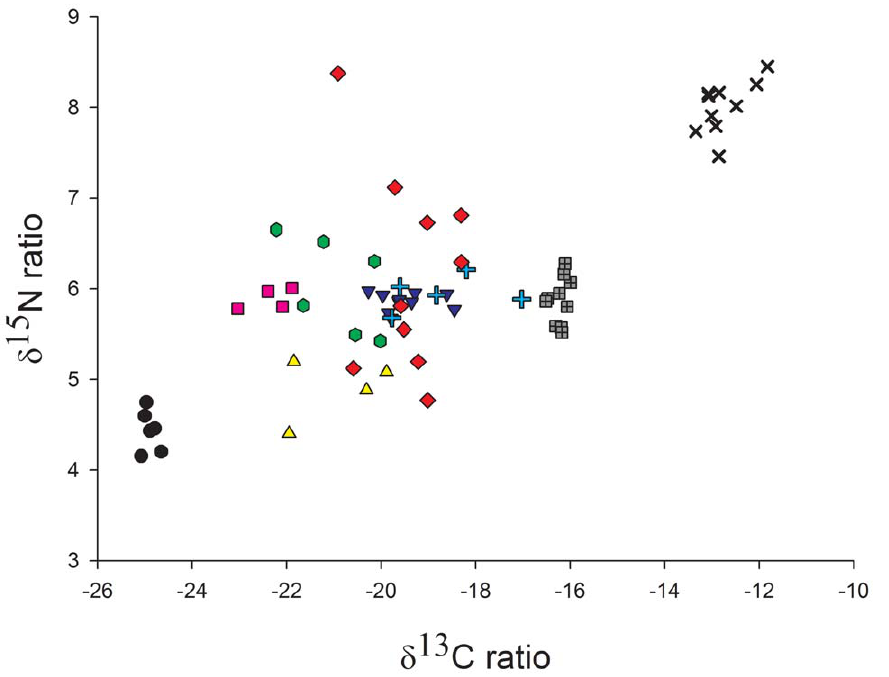
Figure 3. Carbon and nitrogen isotopic values for claw sections from the Cape dune mole-rat, B.suillus . Each colour and symbol represents a single individual showing inter and intra variation in individual